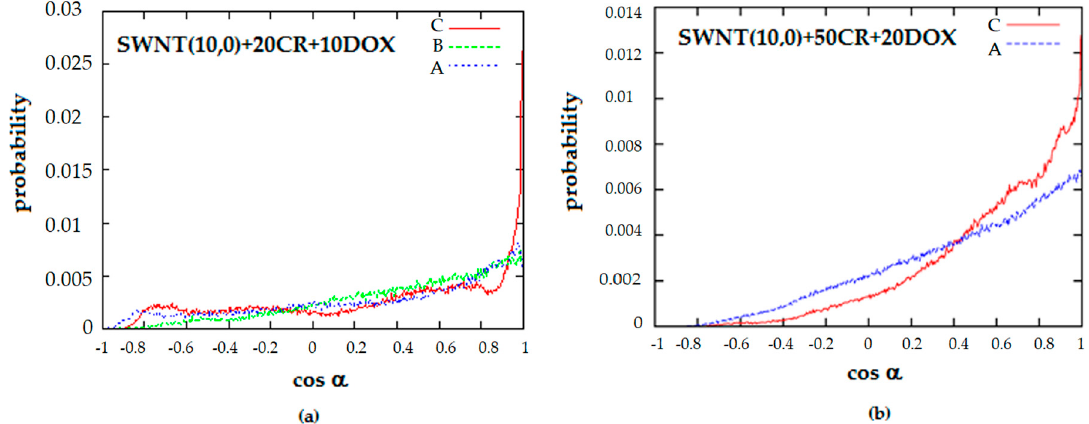
Figure 10. Histograms of cosine of the angle between two CR molecules; ( a ) SWNT (10.0) complexed with 20 molecules of CR and 10 molecules of DOX; ( b ) SWNT (10.0) complexed with 50 molecules of CR and 20 molecules of DOX; (A—neutral pH, B—medium pH, C—acidic pH). The first parameter depicts the planarity of a CR molecule. It was defined as the coe ffi cient of determination R 2 obtained by fitting a plane to the centers of aromatic carbons in a CR